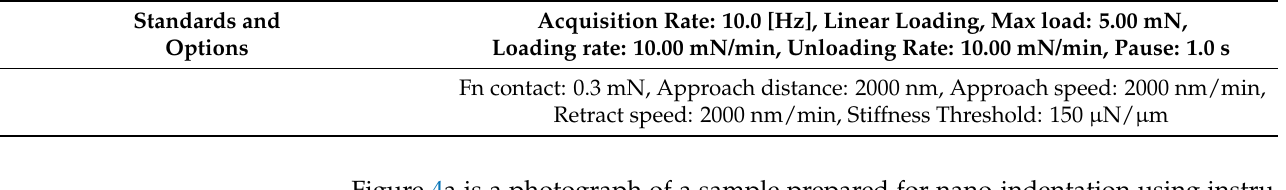
Figure 4. Measured hardness and elasticity. ( a ) Photograph of sample prepared; ( b ) load-depth curves, and ( c ) hardness and elasticity results for the foamed PET–PEN copolymer measured by instrumented indentation technology (sorption at − 20 ◦ C for 24 h, and then post-foaming at 60 ◦ C for 3 min). Table 1. Experimental parameters for the hardness and